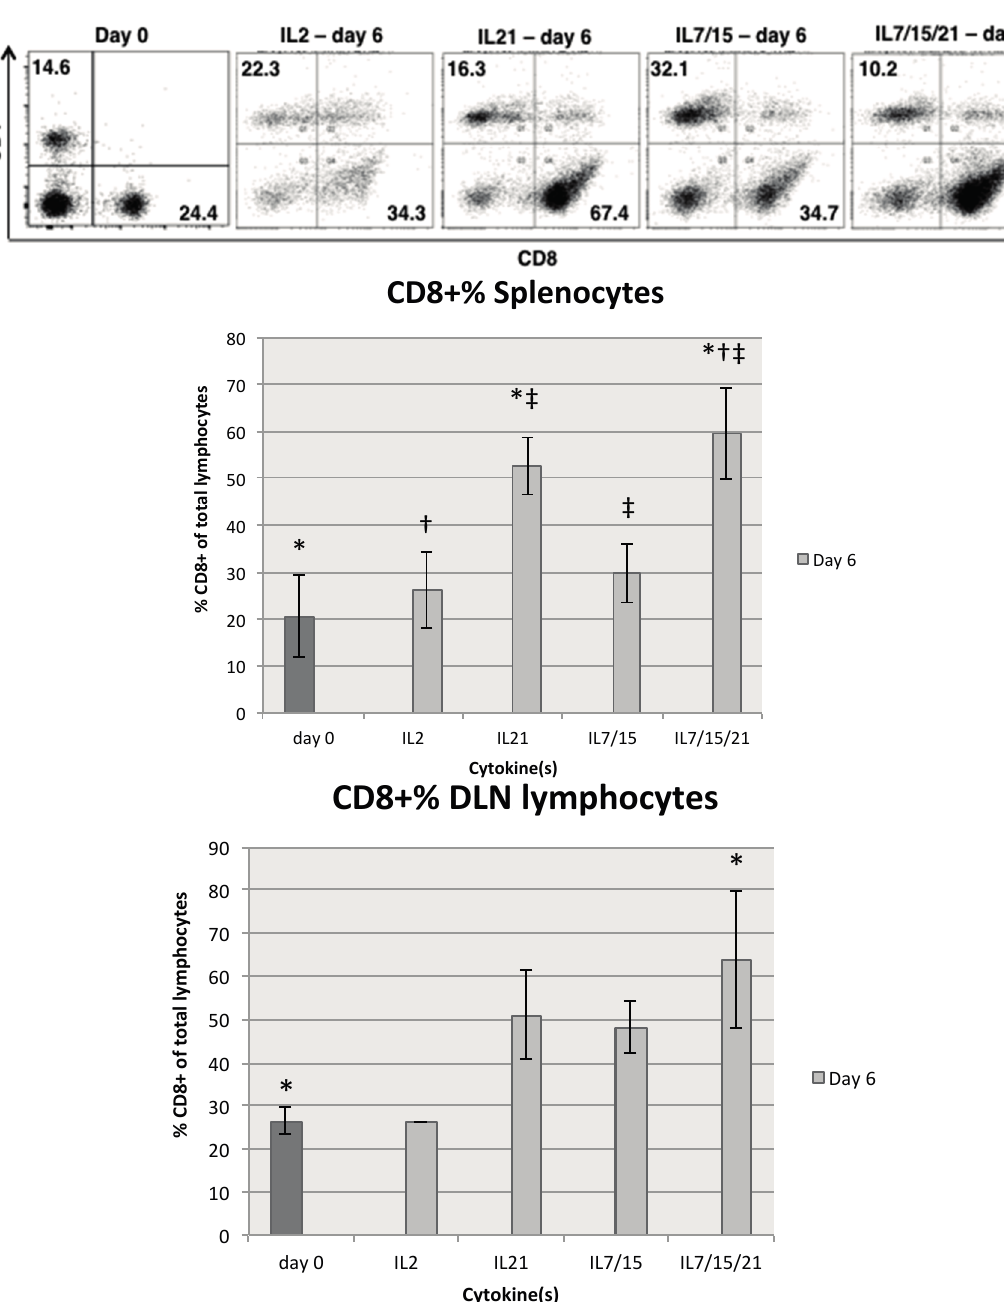
Figure 1. On day 0 before activation with bryostatin-1 and ionomycin (B/I) and six days after B/I activation and culture in IL-2, IL-21, IL-7/15 or IL-7/15/21, splenocytes were stained for CD4 and CD8 and analyzed by flow cytometry ( a ); Cells were FSC/SSC gated on viable lymphocytes and percentages of CD4 and CD8 (numbers in black) were determined. Average percentages of CD8+ T cells from splenocytes in five experiments, * ( vs . day 0) = p < 0.01, † ( vs . IL2) = p < 0.04, ‡ ( vs . IL7/15) = p < 0.05 ( b ) and DLN lymphocytes in three experiments, * ( vs . day 0) = p = 0.03 ( c ) expanded before and after exposure to B/I and six days of IL-2, IL-21, IL-7/15 or